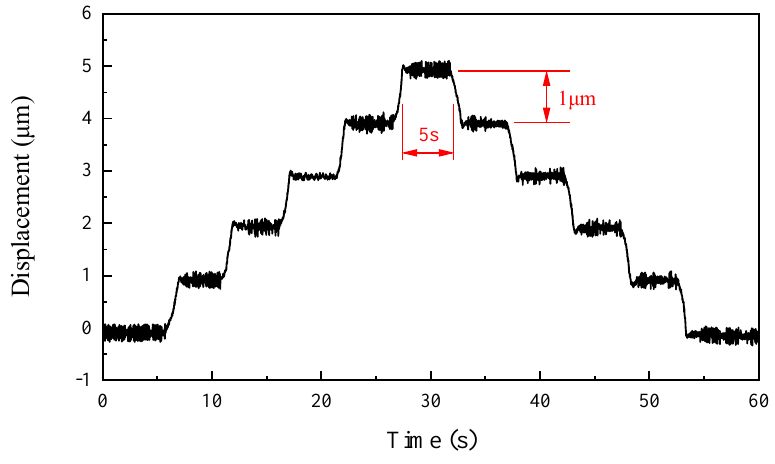
Figure 19. Measured speed ripple at 10 mm/s.